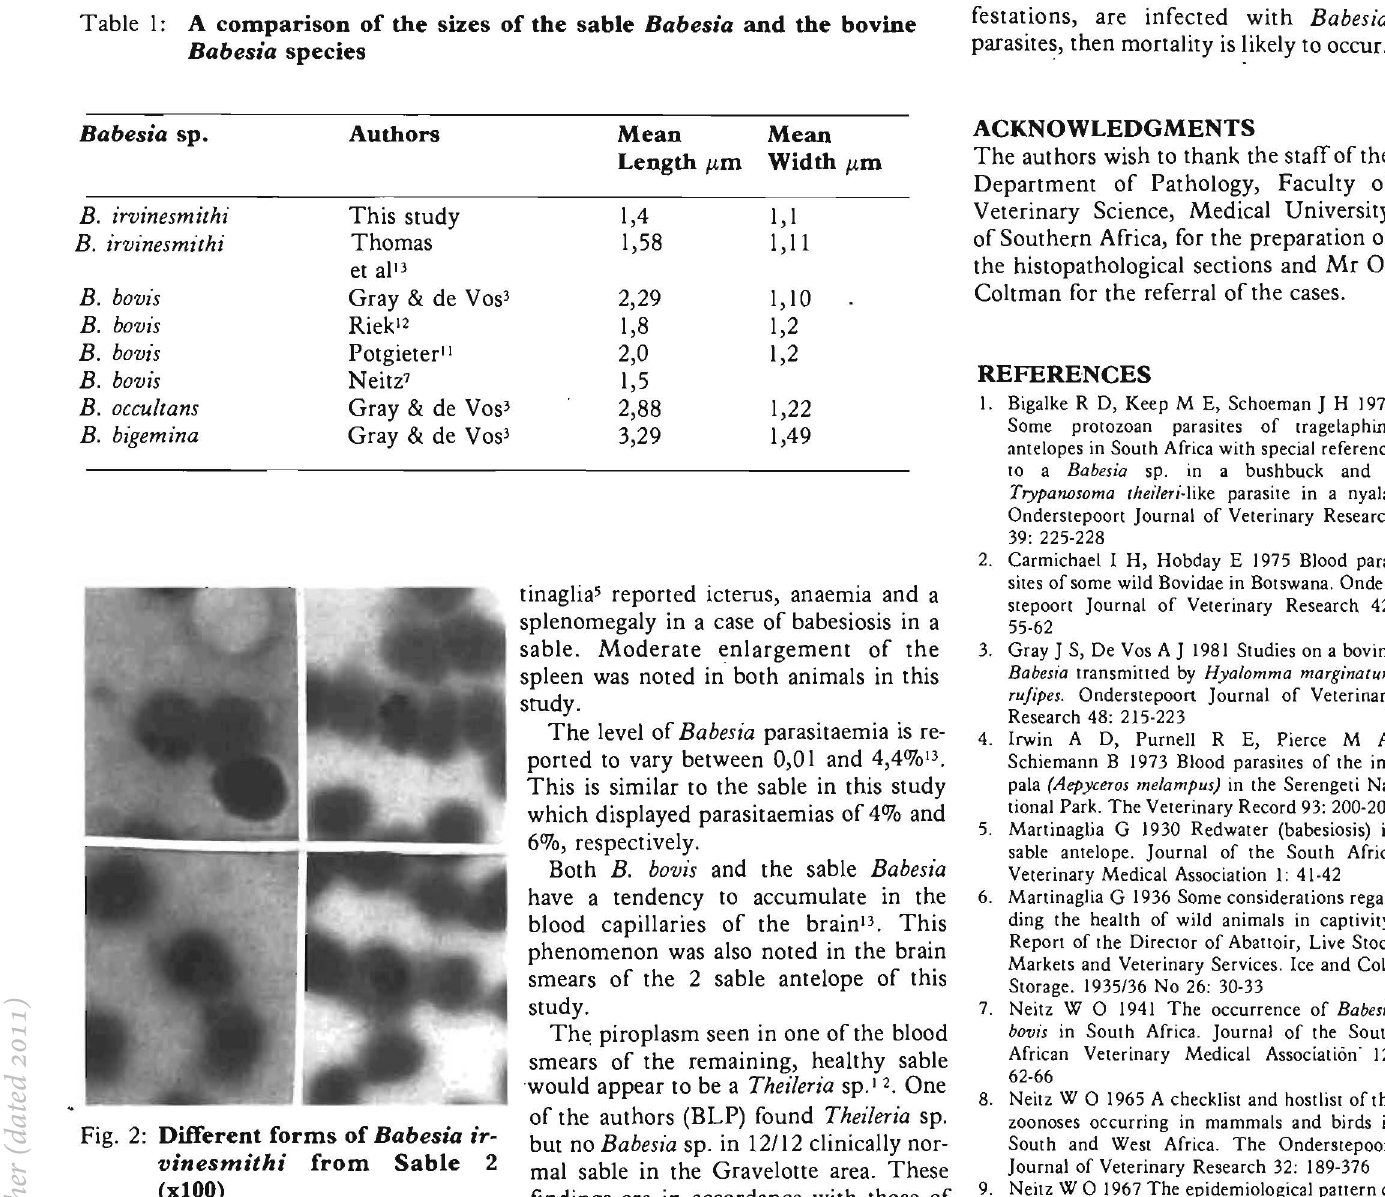
Fig. 2: Different forms of Babesia iT vinesmithi